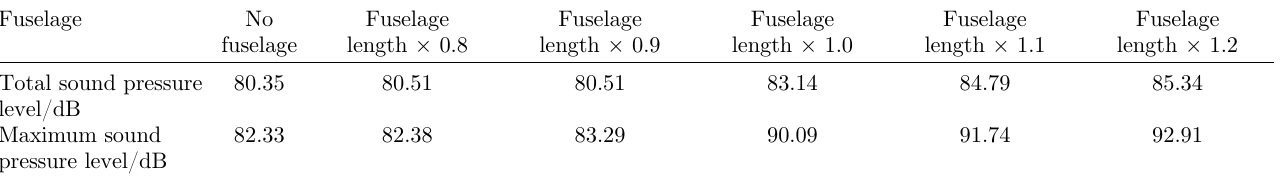
Table 5. Total and maximum SPL of helicopters with fuselages of different length ratios.